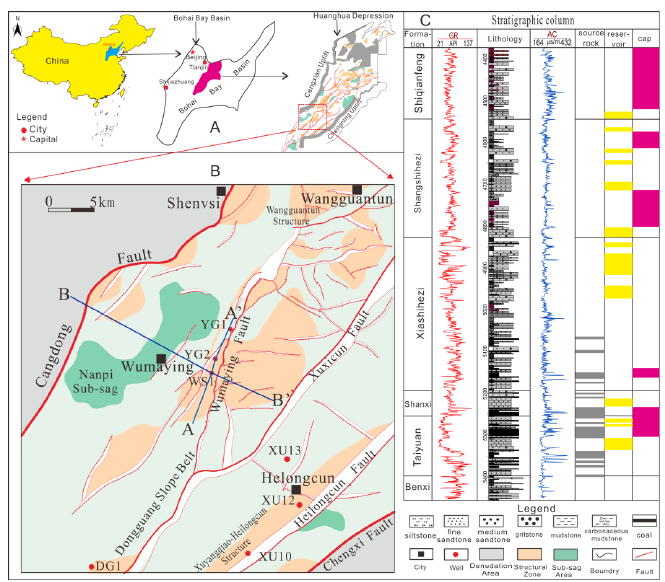
Figure 1. The structure characteristics, position, and stratigraphic column of Carboniferous–Permian of the Wumaying buried hill (modified from [1]). ( A ) Location of Huanghua Depression on the map of China, ( B ) Structural map of Wumaying area, ( C ) Typical stratigraphic column of Upper Paleozoic in Wumaying